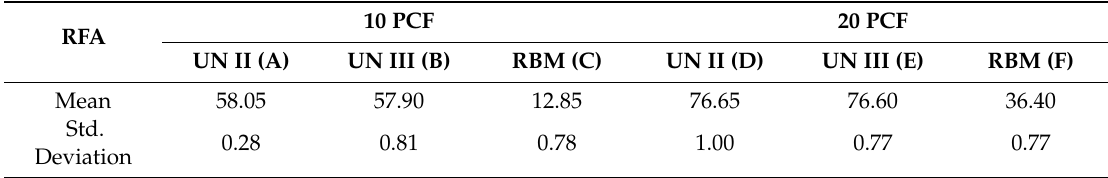
Figure 6. RFA of UN II, UN III, and RBM implants in polyurethane foam blocks (10 pcf; 20pcf). Table 5. Summary of the RFA values of the different experimental groups.